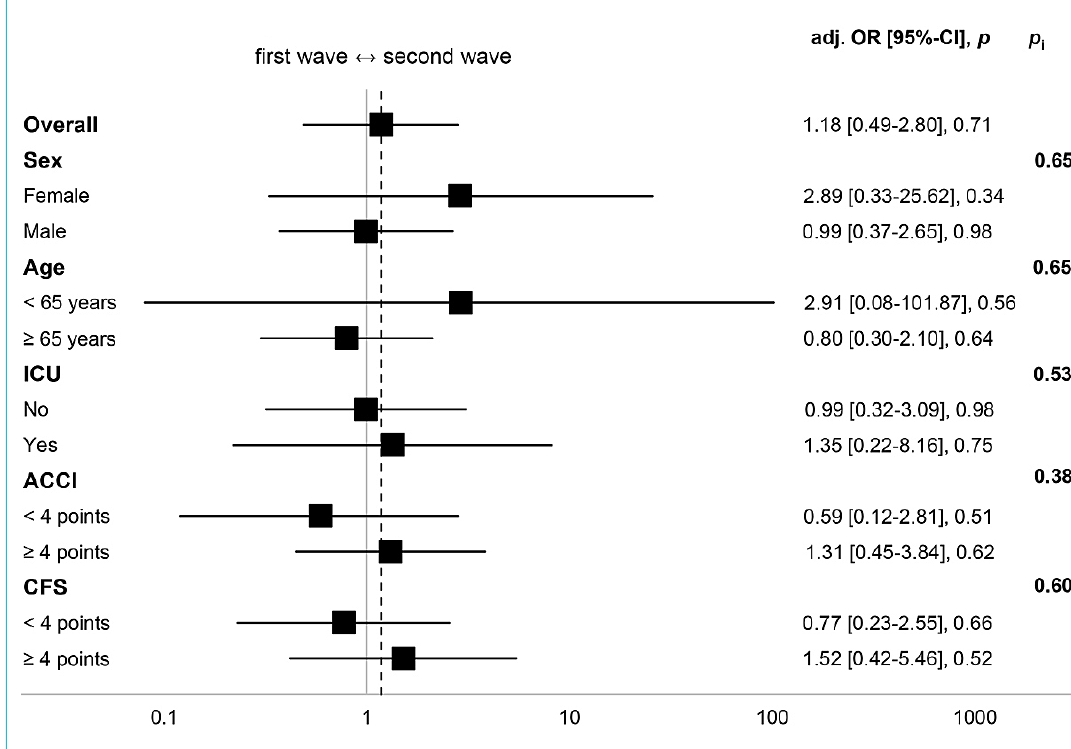
Figure 2: Subgroup analysis for all-cause in-hospital mortality. Fully adjusted OR (Model 2) for wave (base = first wave). Higher ACCI/CFS scores indicate higher burden of comorbidity/frailty. Model 2 adjusted for sex, ACCI, CFS, immunomodulating home medication, time from symptom onset to admission, transfer from other